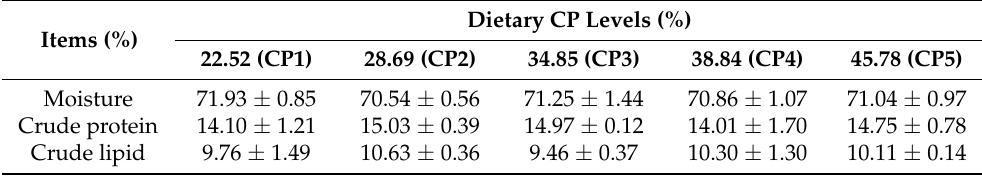
Table 4. Whole body composition of juvenile K. punctatus fed diets containing different CP